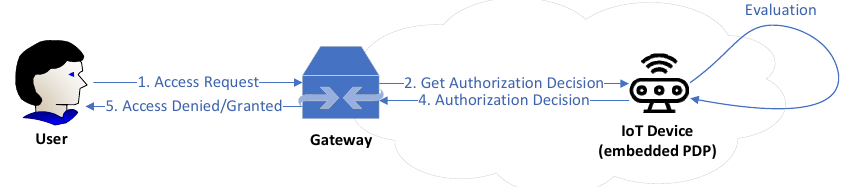
Figure 8. Distributed Approach [48].